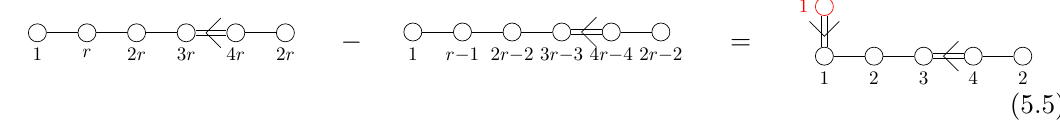
) is a shorthand for the magnetic quiver of S ( r − 1) E 6 , 2